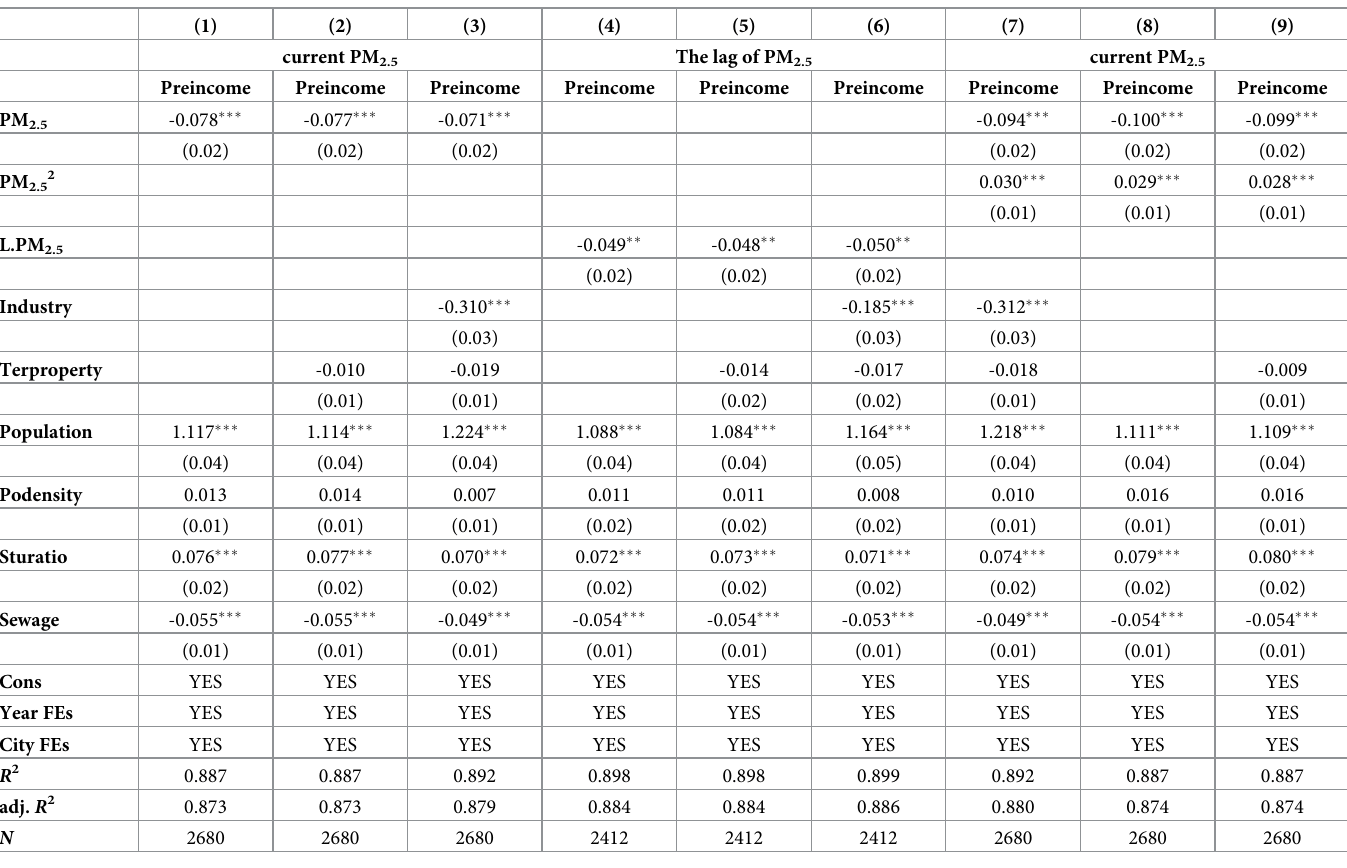
Table 3. Haze pollution and insurance development: Benchmark regression